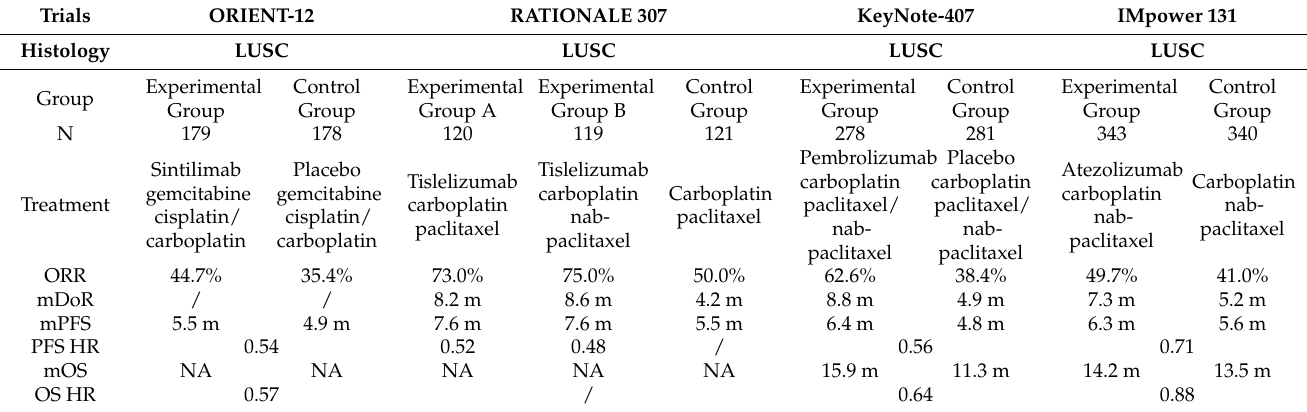
Table 3. The first-line clinical trials of immune checkpoint blockers in advanced